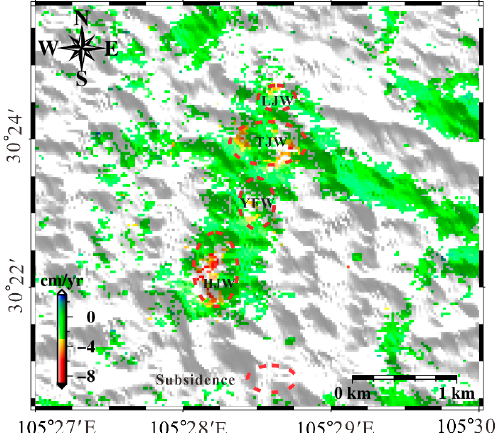
Figure 5. Average subsidence rate from May 2018 to June 2021.